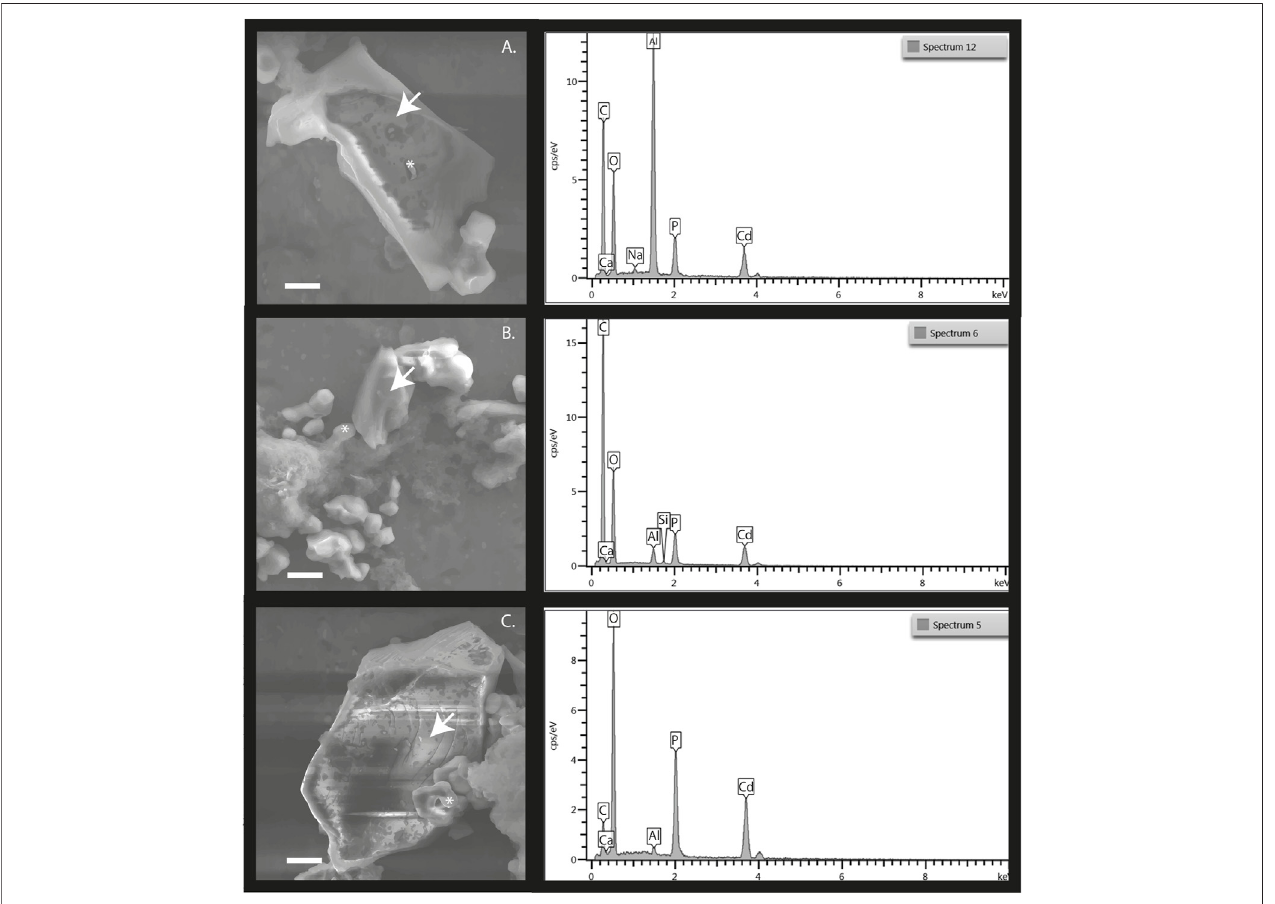
FIGURE 6 | SEM-EDS of composite soil samples from (A) . Antioquia, (B) . Arauca and (C) . Santander. The micrographs shown the presence of CdtB and the presence ofcadmium carbonate or otavite (CdCO 3 ). The white arrows point out the aggregates microbiologically induced. The presence of CdtB is highlighted by white asterisks. the EDS spectra show a greater presence of C, O ions, and the presence of Cd in all cases.